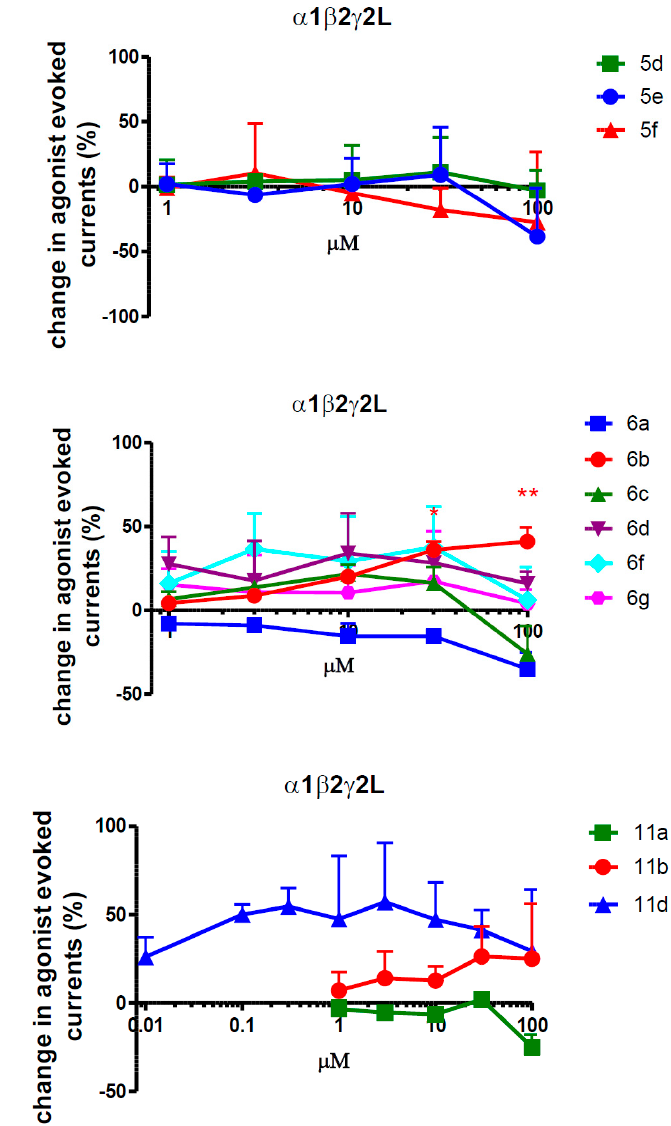
Figure 2. Concentration-response curves of compounds ( A ) 5d – f , ( B ) 6a – d , 6f , g , and ( C ) 11a , b , d on GABA-induced Cl − currents in Xenopus oocytes expressing recombinant α 1 β 2 γ 2L GABA A receptors. Data are expressed as the percentage modulation of the response induced by GABA at EC 5–10 values, and are the mean ± S.E.M of values obtained from two to nine oocytes. ** p < 0.01; * p < 0.05 Kruskal–Wallis test followed by the Dunn post-hoc test.